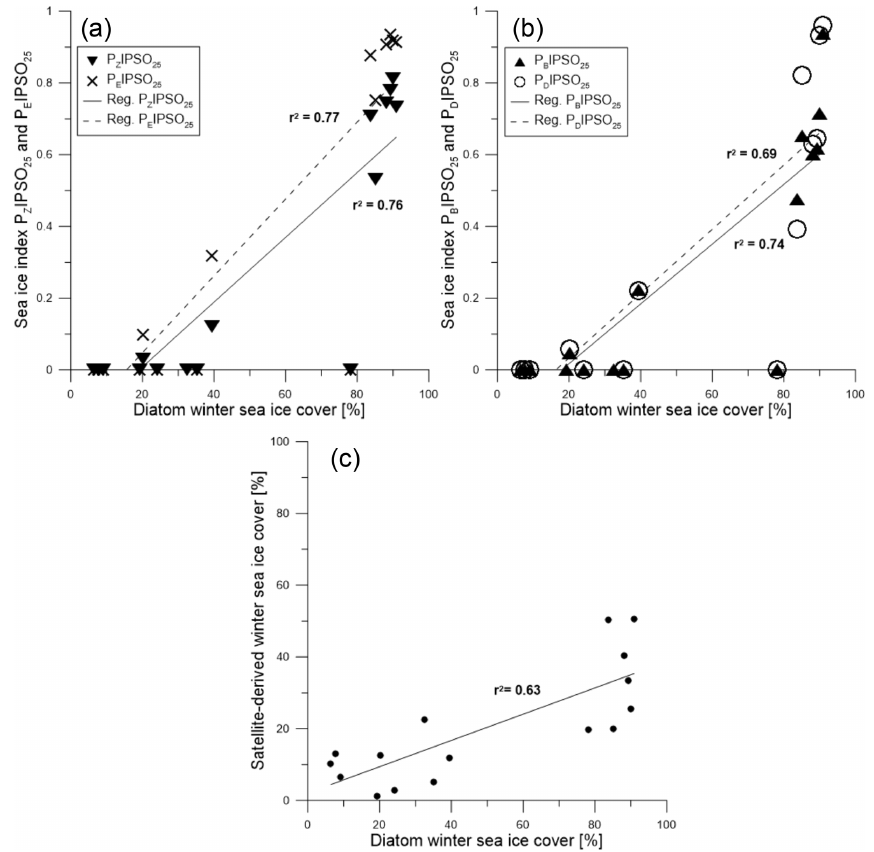
Figure 8. Scatter plots of (a) P Z IPSO 25 (triangles, solid regression line) and P E IPSO 25 (crosses, dashed regression line) and (b) P B IPSO 25 (triangles, solid regression line) and P D IPSO 25 (circles, dashed regression line) against diatom-derived winter sea ice concentrations. (c) Scat- ter plot of diatom transfer function winter sea ice concentrations and satellite winter sea ice